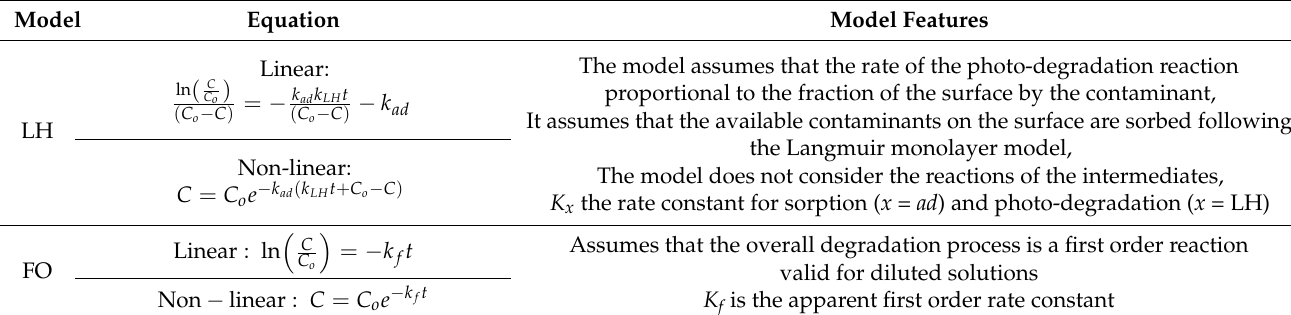
Table 7. Models used in analyzing the photo-degradation kinetics. Model Equation Model